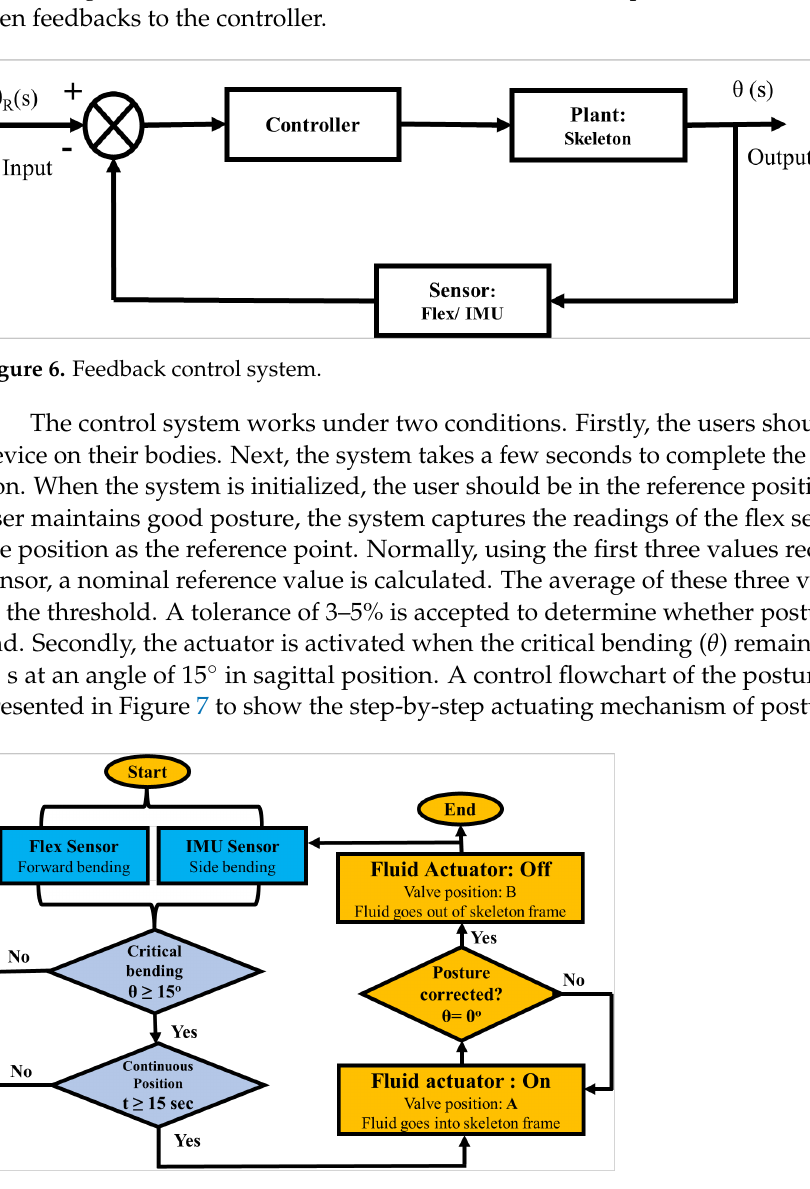
Figure 7. The control flowchart of the posture